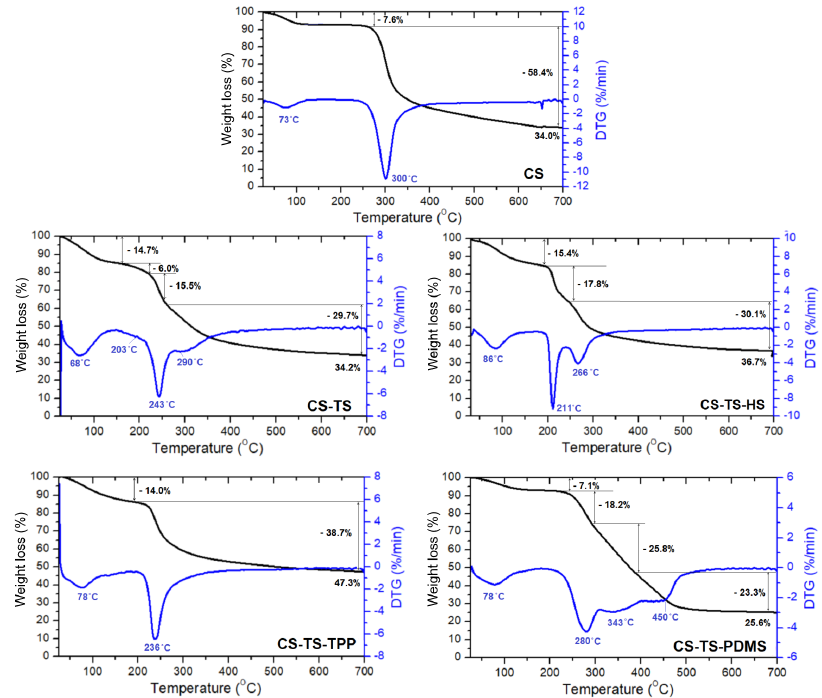
Figure 4. TG/DTG curves of CS-TS , CS-TS-HS , CS-TS-TPP, and CS-TS-PDMS composite membranes Figure 4. TG / DTG curves of CS-TS, CS-TS-HS, CS-TS-TPP, and CS-TS-PDMS composite membranes compared with pristine chitosan (CS). compared with pristine chitosan